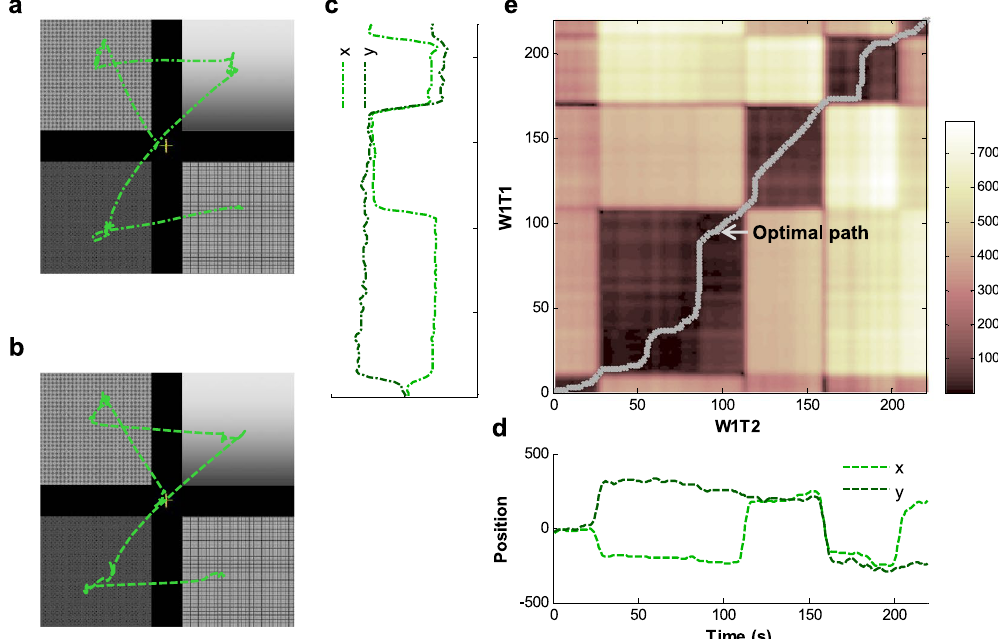
Figure 3. An example of dissimilarity calculation between two scanpaths with DTW. ( a ) A scanpath of subject #20 on image set #47 in session W1T1 and ( b ) one in W1T2. The four images in image set #47 are not shown due to their copyrights; thus, the areas for these images are covered with randomly assigned patterns. The scanpaths in (a) and (b) can be presented in the time domain as ( c ) and ( d ), respectively. ( e ) A matrix of Euclidean distance between every point of ( c ) and ( d ). Each component is a distance between one point from ( c ) and one from ( d ). The grey path is determined by dynamic programming, and the accumulated distance along this line is defined as dissimilarity between ( c ) and ( d ). In this example, the dissimilarity between ( c ) and ( d ) is 12,353. The possible range of the dissimilarity value is from 0 to